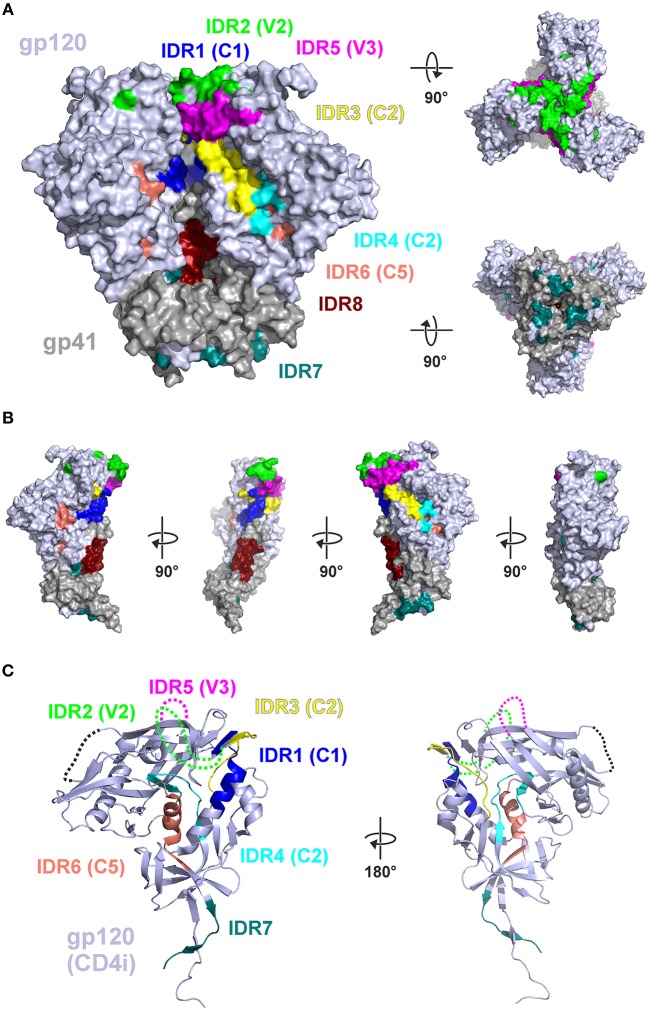
Mapping of immunodominant peptide regions (IDR) to the structure of Env. (A) Color-coded solvent accessible surface area (SASA) of the eight IDRs projected on a native like Env trimer (C-clade consensus structure, PDB ID 8ck9). Glycans were removed and IDRs are highlighted in all protomers. Both IDR5.1 and IDR5.2 are combined as IDR5. (B) Eight IDRs projected onto the surface of a gp120-gp41 protomer from (A). (C) Location of the IDRs in the context of a CD4-induced (CD4i) gp120 structure (PDB ID 3jwd). Variable loops 1–4 which are deleted or not resolved in the structure are symbolized by dotted lines.